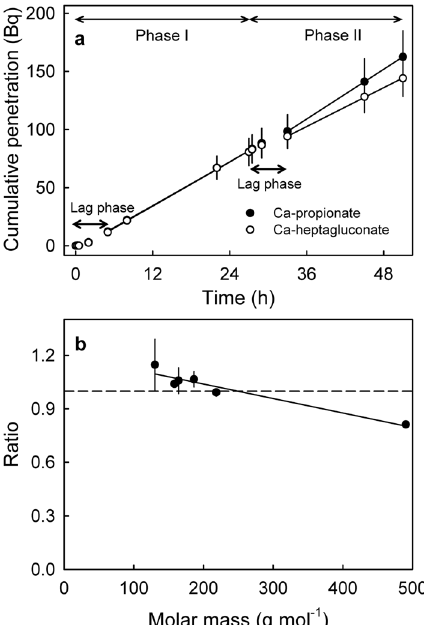
Figure 2. ( a ) Time course of penetration of 45 Ca-salts from a donor solution through an excised skin segment of mature sweet cherry fruit into a receiver solution. In phase I of the experiment, the steady state flow rate of 45 Ca was established using 45 CaCl 2 as the donor solution. At the beginning of phase II, the 45 CaCl 2 donor solution was replaced by one of the following salt solutions: 45 Ca(NO 3 ) 2 , 45 Ca-formate, 45 Ca-acetate, 45 Ca-lactate, 45 Ca-heptagluconate or 45 Ca-propionate. The steady state flow rates were re-established. Steady states flow rates and permeances were calculated from the slopes of regression lines fitted through the linear portions of plots of cumulative penetration vs. time. From these flow rates, permeances were calculated (for details see “Material and methods”). For permeance estimates see Table 2. ( b ) Ratio of permeances during phase II divided by phase I ( 45 CaCl 2 ) as a function of molecular size. The dashed line represents the ratio value 1.0, where the permeance during phase II is identical to that during phase I.